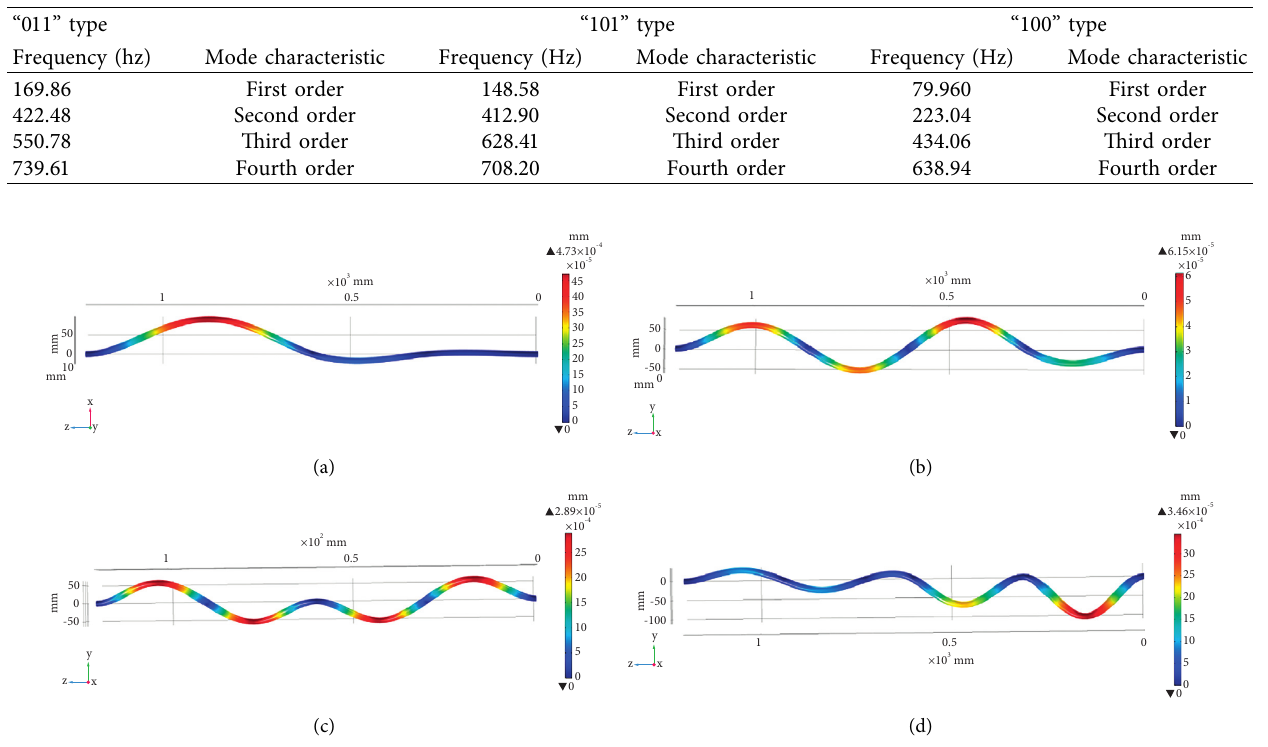
Table 4: Calculation results of natural frequencies different failure modes.